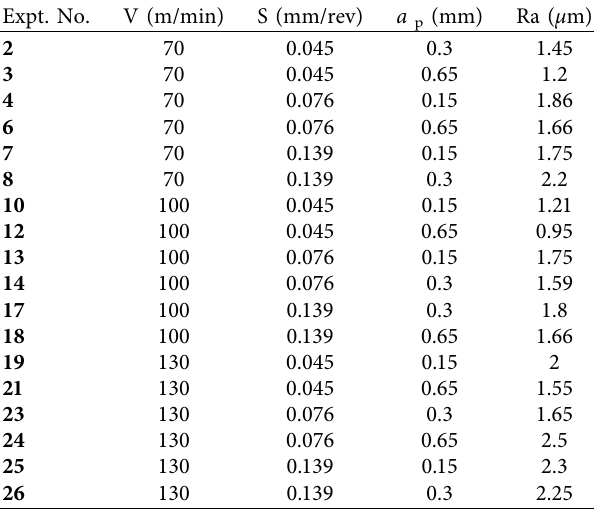
Table 4: The training dataset with target output.